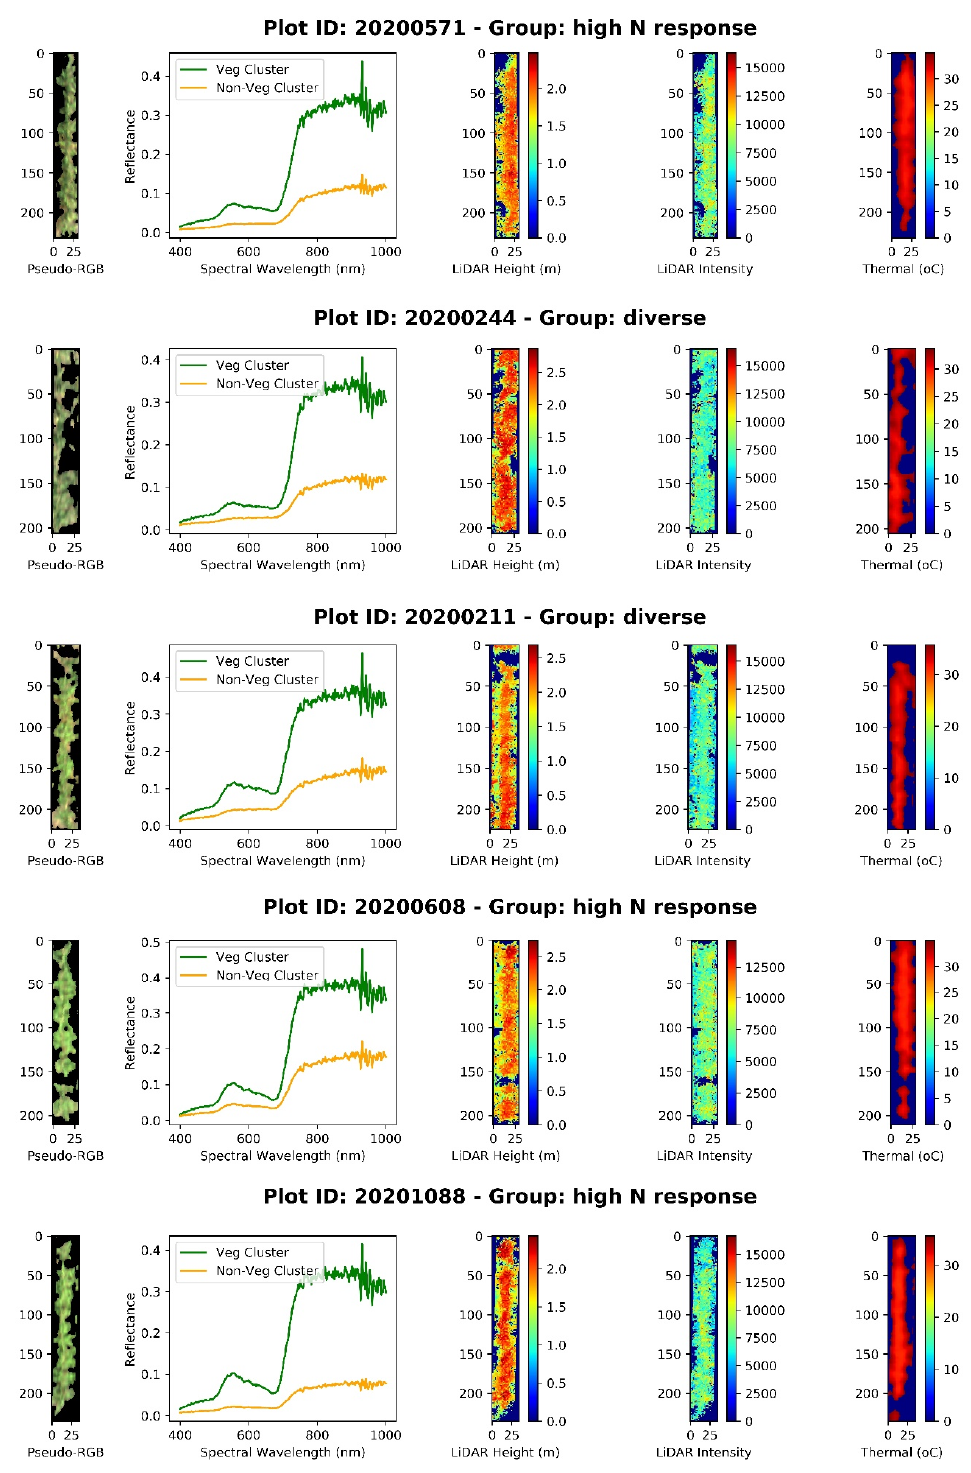
Figure 5. The segmentation results of 5 random plots using k -means clustering to extract pure vegetation pixels (Areas of interest, AOIs) from non-vegetation pixels (soil, crop residuals, heavy shadow, etc.). The segmentation was done on weed-free sample plots instead of the ortho-mosaic image of the entire field that possibly contained weeds. The hyperspectral profiles of pure vegetation were again verified and affirmed with LiDAR height and intensity, and thermal.